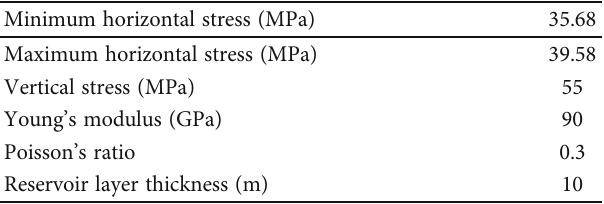
Table 2: Basic parameters of the upper and lower